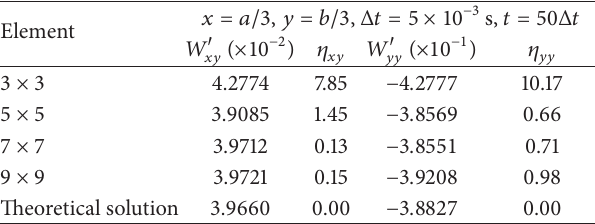
Table 3: Manifold results of the displacement partial derivatives and their relative errors.